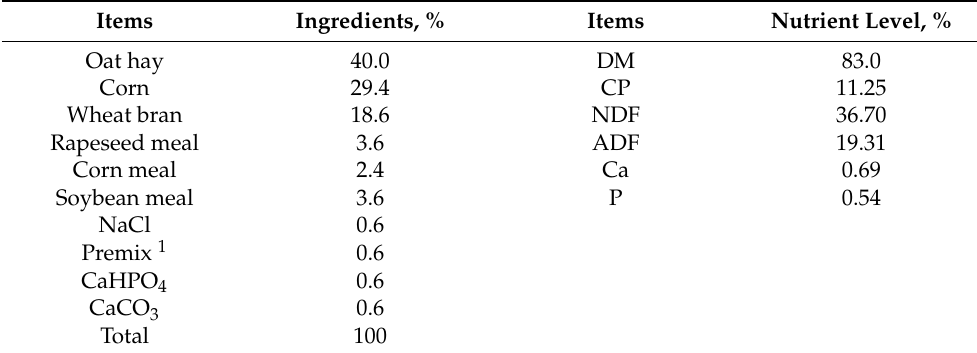
Table 1. The ingredients and nutrient level of concentrated feed (dry matter basis,